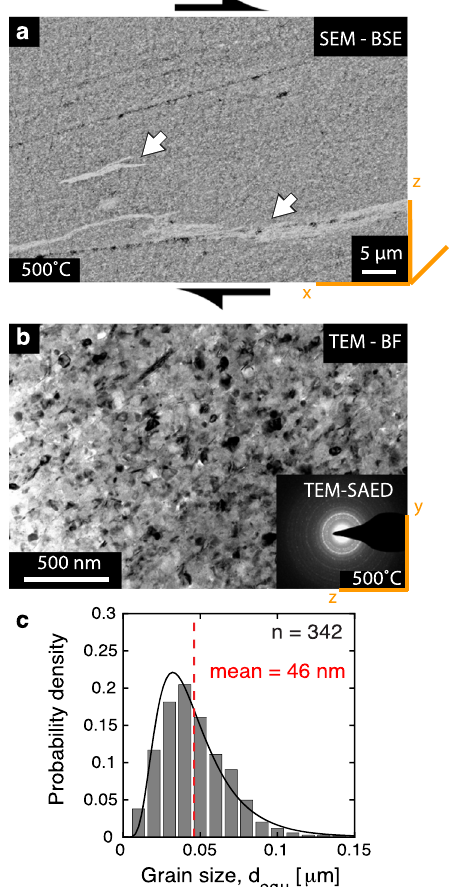
Fig. 4 Microstructural observations at high magni fi cations in SEM and TEM. a Microstructure at 500 °C, fracture-free portion with folds and stretched layers (white arrows) indicating continuous deformation, i.e., fl ow. b TEM bright- fi eld image of nanocrystalline fault rocks deformed at 500 °C. FIB foil was cut fl ow perpendicular. Inset shows selected area diffraction pattern (SAED). Notice the equal distribution of diffracting spots suggesting that the material is nanocrystalline with no strong CPO. c Grain size distribution of the silicate minerals in ( b